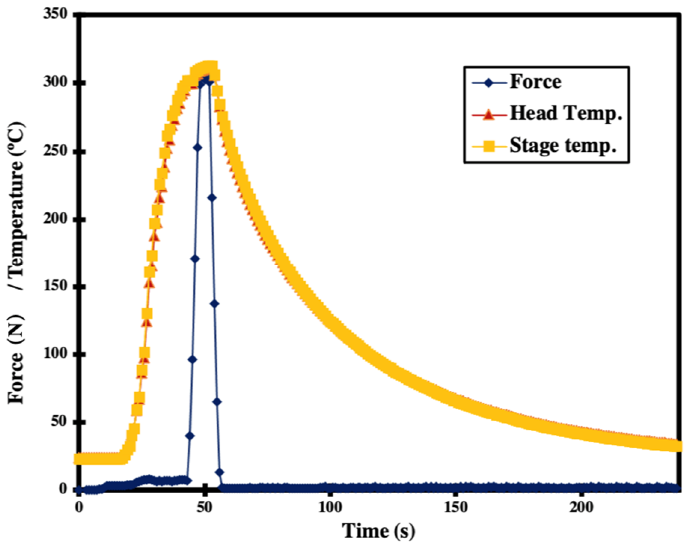
Figure 4. Process profile of temperature and bonding force vs. bonding time in the first step with an applied bonding force of 93 MPa. applied bonding force of 93